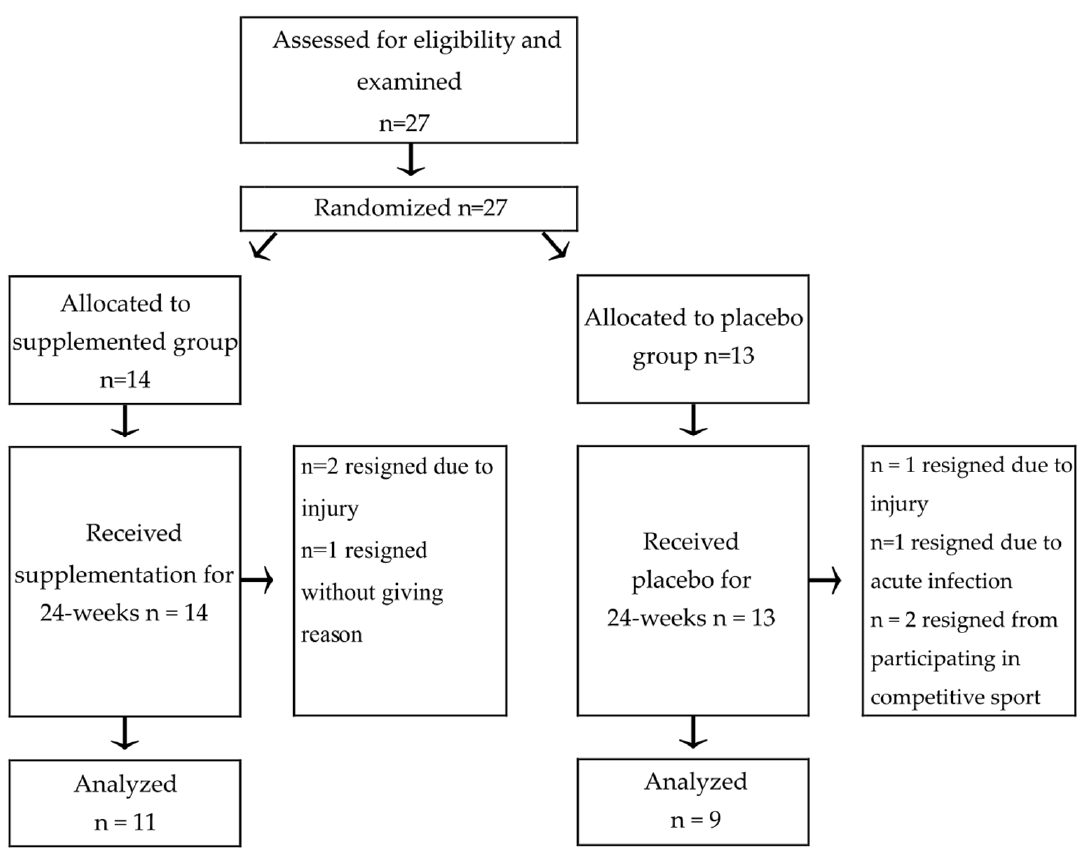
Figure 1. The flow chart shows the recruitment process of participants in the trial.